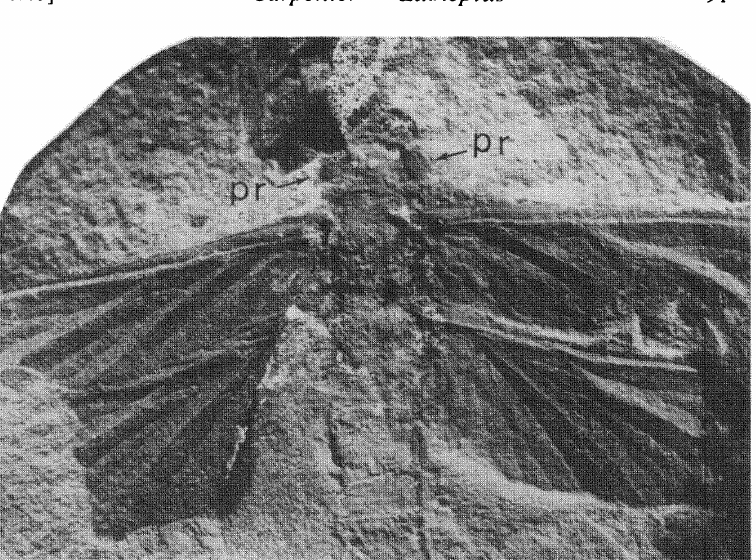
Figure 6. Eubleptus danielsi. Photograph of specimen YPM 18 (holotype of Ath.v- modict.va parva Handlirsch. Dorsal view (reverse); pr, pronotal lobes, maximum width of left fore wing in photograph, 4